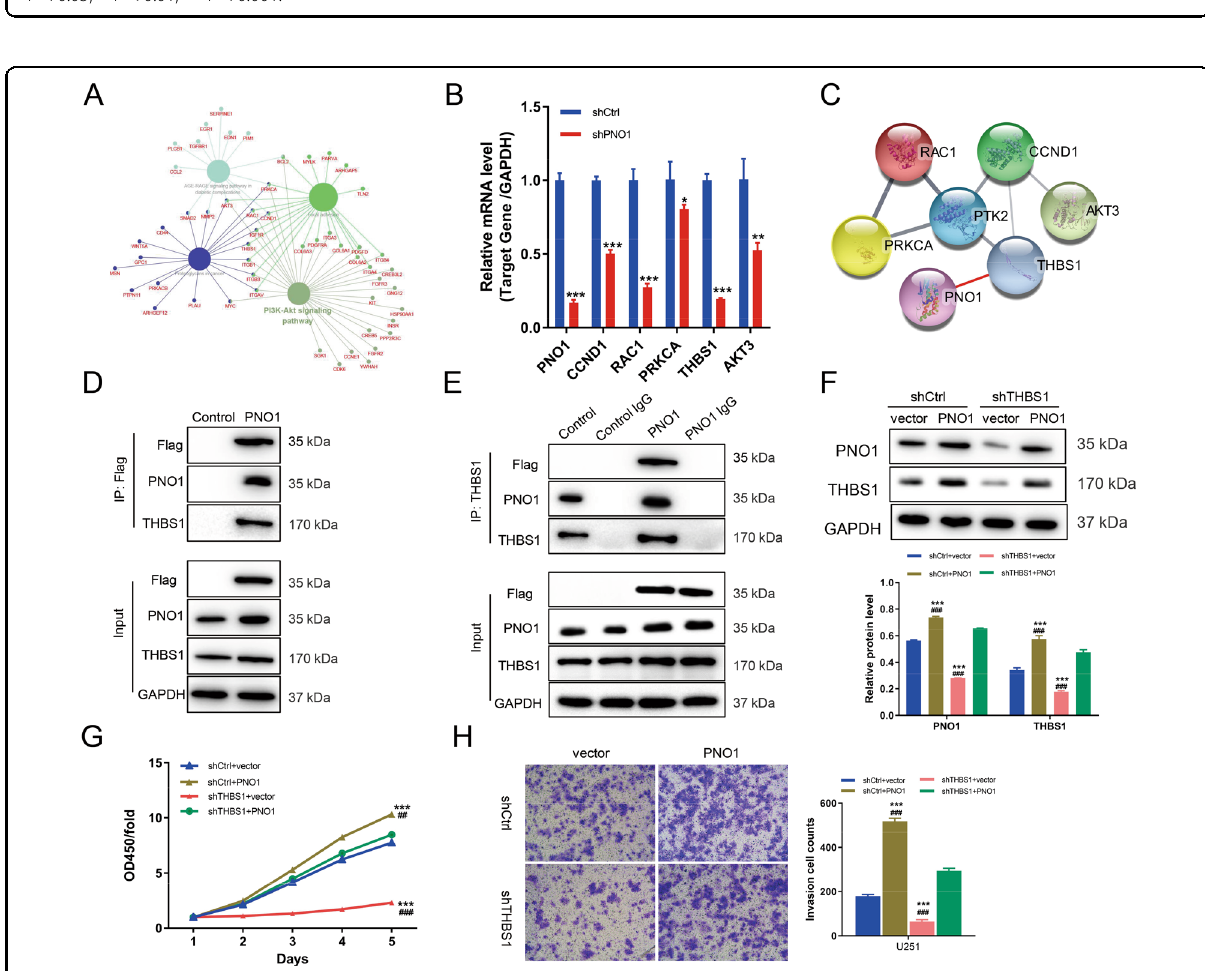
Fig. 5 THBS1 acts as the potential target of PNO1 in the regulation of glioma. A KEGG Pathway Enrichment Analysis of these DEGs from microarray analysis. B RT-PCR showing the intersection DEGs from KEGG Pathway Enrichment Analysis. n = 3, *P < 0.05, ** P < 0.01, *** P < 0.001. C Using the STRING program to analysis potential interactions between PNO1 and the fi ve intersection DEGs. FAK, also known as PTK2, was the central of the DEGs. Co-immunoprecipitation (IP) analysis in U251 cells after PNO1 overexpression was performed to determine the binding of PNO1 to THBS1 using anti-FLAG antibody ( D , FLAG-tag overexpressing PNO1) or anti-THBS1 antibody ( E ). F Western blotting showing the protein expression levels in U251 cell lines infected with PNO1 overexpression or the control (vector), and transduced with or without shTHBS1 or shCtrl. G Cell viability was determined using the CCK-8 assay. U251 cells were infected with PNO1 overexpression or the control (vector), and transduced with or without shTHBS1 or shCtrl. n = 3, ** , ## P < 0.01, ***, ### P < 0.001, * vs. shCtrl + vector, # vs. shTHBS1 + vector. H Cell invasion was determined using the transwell assay. U251 cells were infected with PNO1 overexpression or the control (vector), and transduced with or without shTHBS1 or shCtrl. n = 3, *** , ### P < 0.001, * vs. shCtrl + vector, # vs. shTHBS1 +